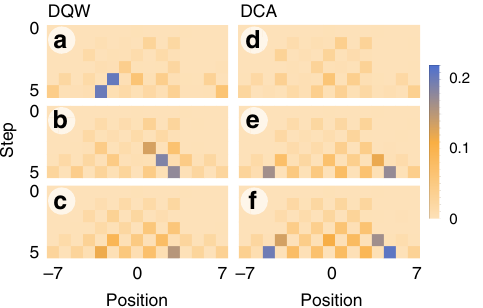
Fig. 4 Experimental errors. Experimental error distribution for DQW (left) and DCA (right).